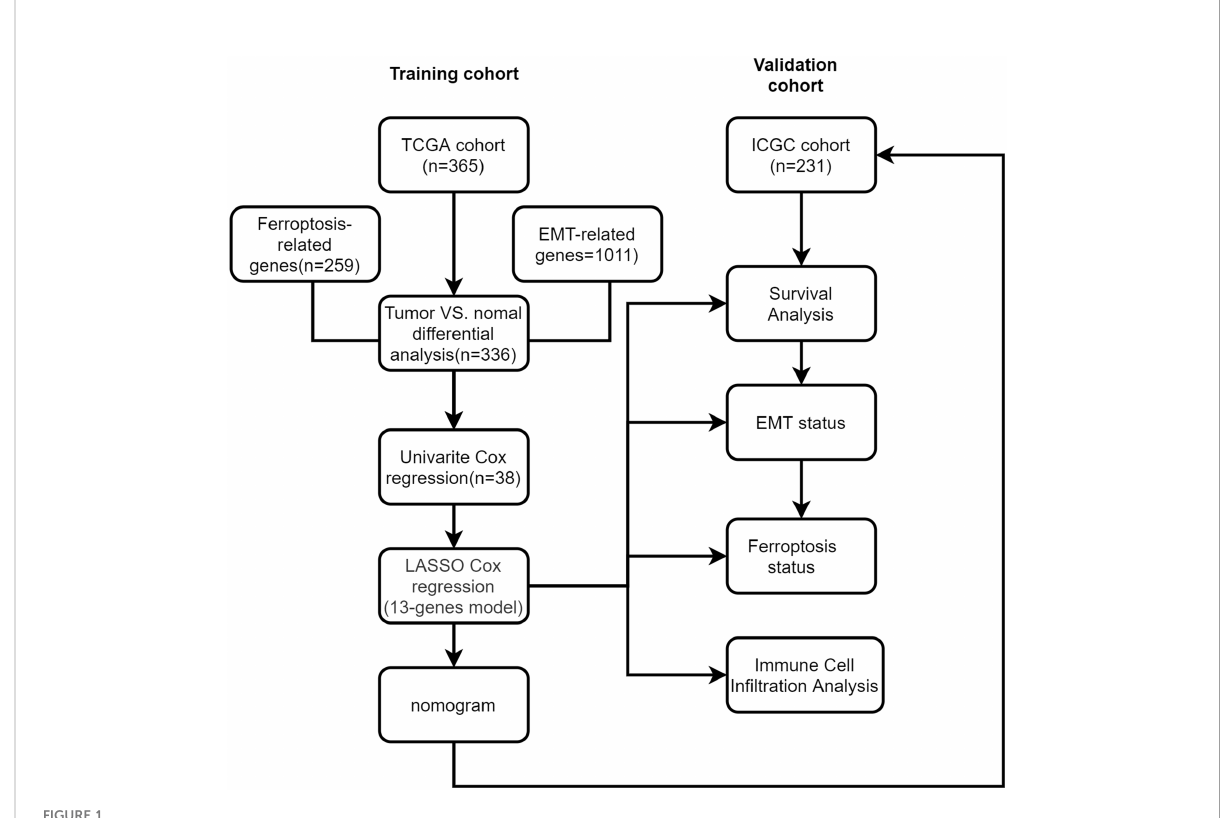
FIGURE 1 Study fl ow